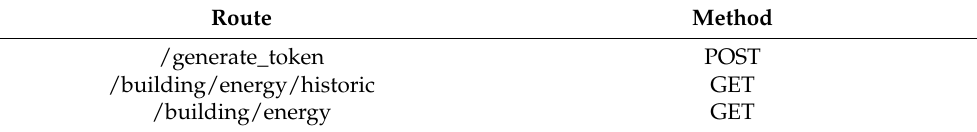
Table 1. Routes available in the REST